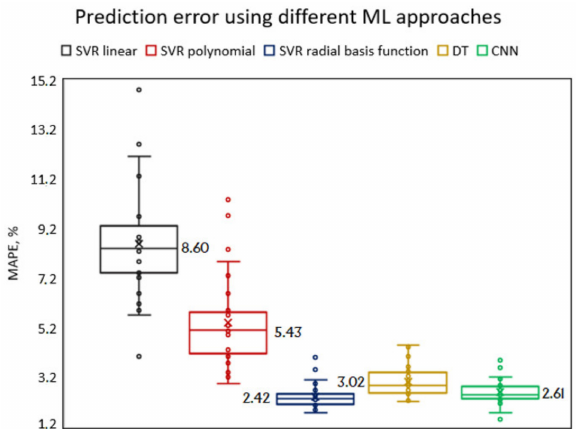
Figure 25. Comparison results for different ML algorithms MAPE (SVR with different kernels, DT and CNN) represented using